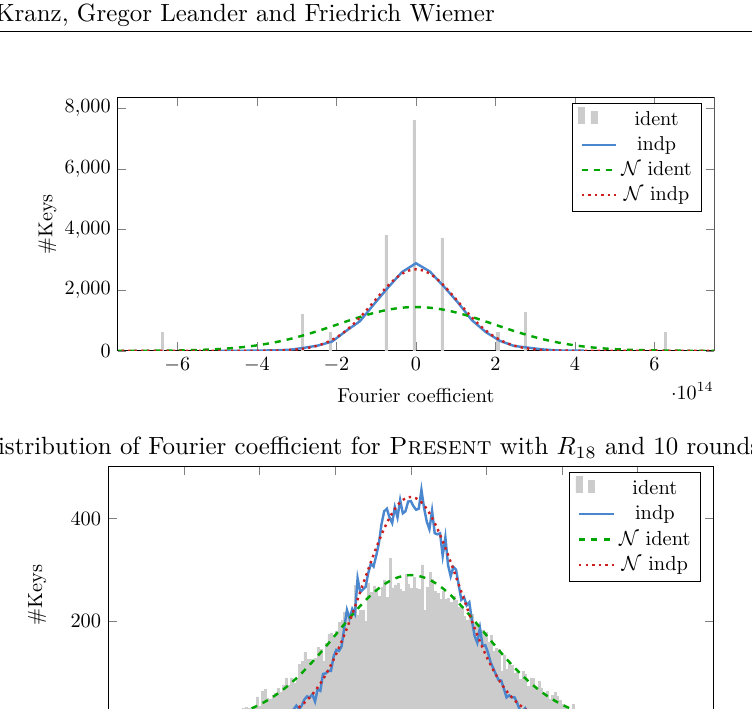
Distribution of Fourier coefficient for Present with R 19 and 10